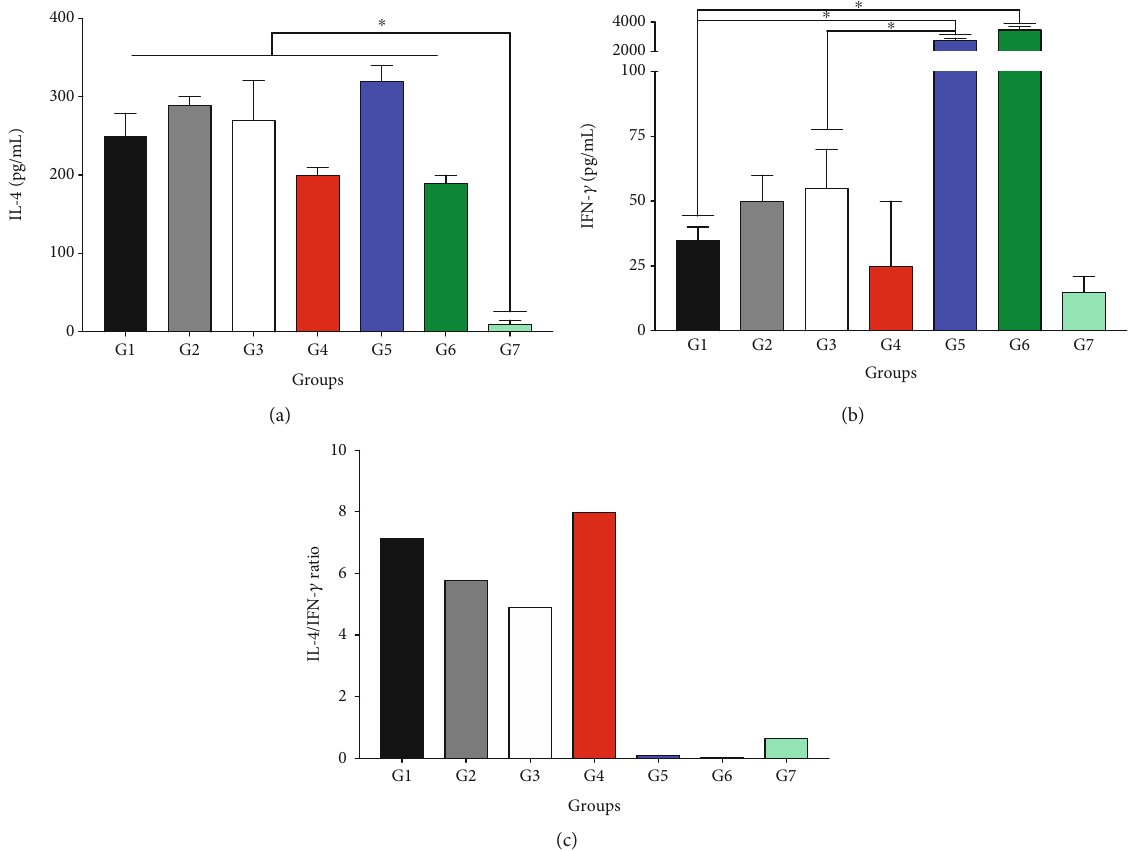
Figure 4: Mononuclear cells from lymph nodes of treated and control BALB/c mice were isolated and cultured by 72 h under speci fi c stimulation with the whole antigen of L. (L.) amazonensis , following the levels of IL-4 (a) and IFN- γ cytokines (b) which were quanti fi ed by ELISA. (c) IL-4/IFN- γ ratio. ∗ p < 0 : 05 indicates statistical signi fi cance. G1: infected control; G2 and G3: animals treated with blank SNEDDS or blank SNEDDS gels, respectively; G4: animals treated with BUT-SNEDDS; G5: animals treated with BUT-SNEDDS gel; G6: animals treated with butena fi ne; G7: animals treated with